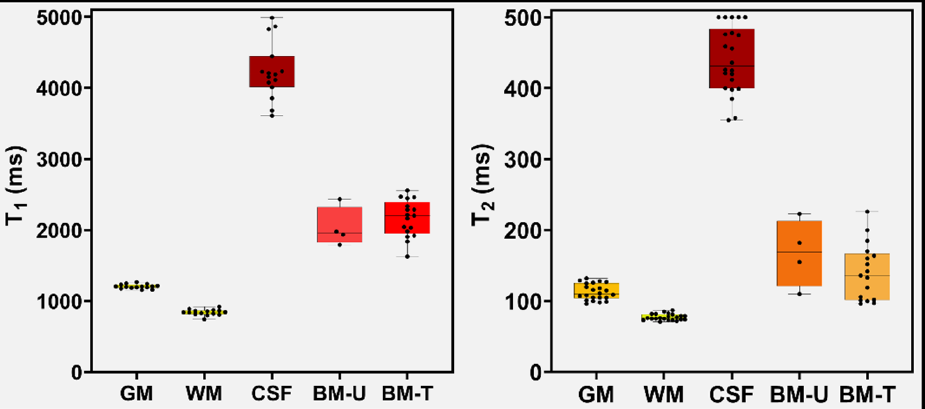
Figure 4. Analytics of the T1 and T2 values for normal-appearing GM, WM, CSF, untreated (U) and treated (T) BM using the T1 and T2 maps generated from MRF method. Boxes represent the interquartile range, whiskers represent the range of all values, and the horizontal line within the box is the median value.